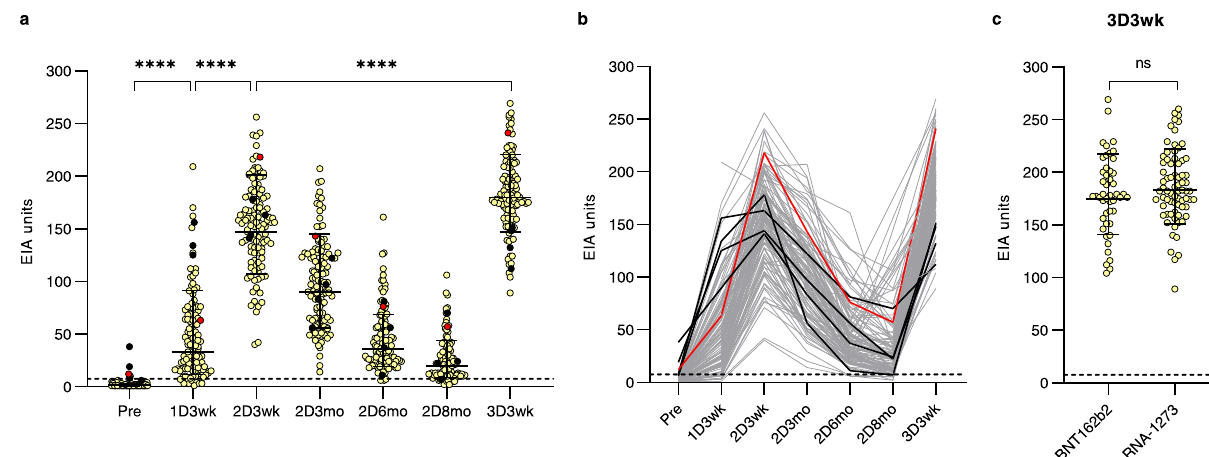
Fig. 3 Antibody responses of HCWs after receiving two doses of COVID-19 mRNA vaccines with a short vaccine dose interval and the third booster dose of mRNA vaccines. a, b SARS-CoV-2 S1-speci fi c IgG antibody levels were measured with EIA from serum samples collected before the vaccination (Pre; n = 108), three weeks after the fi rst vaccine dose (1D3wk; n = 119), three weeks (2D3wk; n = 120), three months (2D3mo; n = 120), six months (2D6mo; n = 119), and nine months (2D8mo; n = 109) after the second vaccine dose, and three weeks after the third booster vaccine dose (3D3wk, n = 120). Vaccinees received two doses of the BNT162b2 vaccine and the third dose of BNT162b2 or mRNA-1273. Sequential serum samples are connected with lines. HCWs with a prior PCR con fi rmed SARS-CoV-2 infection are represented with black lines and a PCR-con fi rmed breakthrough infection after the second dose is represented with a red line. The dotted line indicates the cut-off value for S1-based EIA. c Vaccinated HCWs are separated into two groups based on the third booster vaccine dose (BNT162b2, n = 47 vs. mRNA-1273, n = 73) and anti-S1 IgG antibody responses three weeks after the third booster dose is compared. Geometric mean antibody levels are shown as lines with geometric SD. Statistical differences between samples collected before vaccination, and three weeks after each vaccine dose were analyzed with two-sided Wilcoxon signed-rank test. Differences between different vaccine groups were compared with unpaired t -test. Two-tailed P -values < 0.05 were considered statistically signi fi cant. P -values of **** in panel a are <0.0001, ns not signi fi